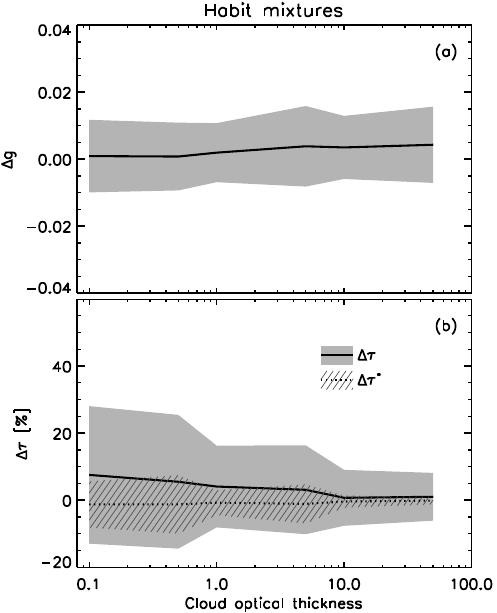
Fig. 9. As for Fig. 7, but for simulated data assuming various ice crystal habit mixtures.